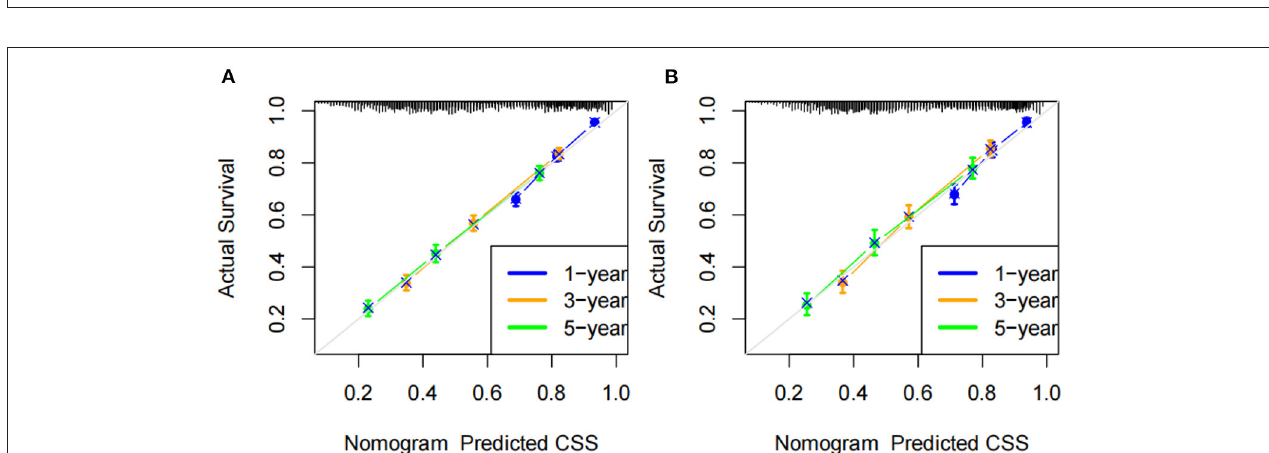
FIGURE 3 | Calibration curve of the nomogram. (A) Calibration curves of 1-, 3-, and 5-year CSS in training cohort; (B) calibration curves of 1-, 3-, and 5-year CSS in the validation